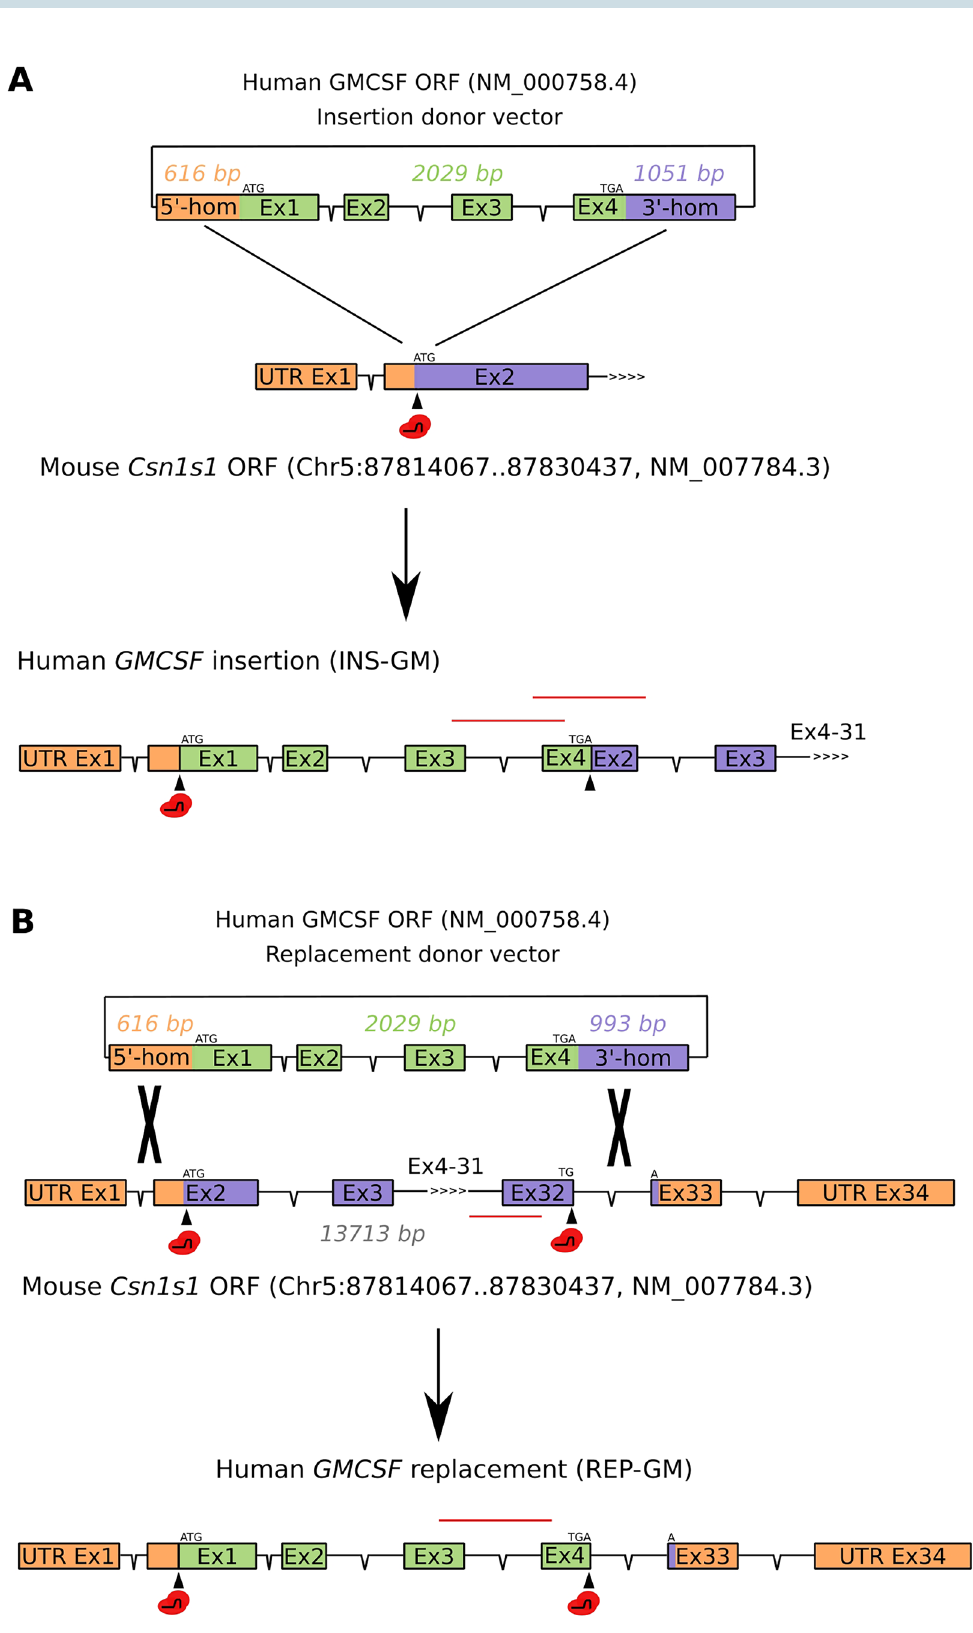
Figure 1. Targeted integration of the hGMCSF transgene into the Csn1s1 locus using CRISPR/Cas9 approach. ( A ) Structure of the hGMCSF donor vector and its insertion into the Csn1s1 Exon 2. ( B ) Replacement of the Csn1s1 coding sequence with the hGMCSF donor vector. Wild type mouse Csn1s1 ORF is shown below the vector. Red lines indicate transcript exon-splice sites used for ddPCR expression analysis. Red bubbles symbolize Cas9 cut sites. ATG, TGA—start and stop codons,